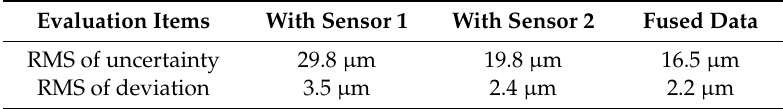
Figure 9. Deviations from the underlying surface from the results of: ( a ) Sensor 1; ( b ) Sensor 2; and ( c ) fused data. Table 1. RMS (root mean squared) value of associated uncertainties of the original measurement datasets and fused dataset.